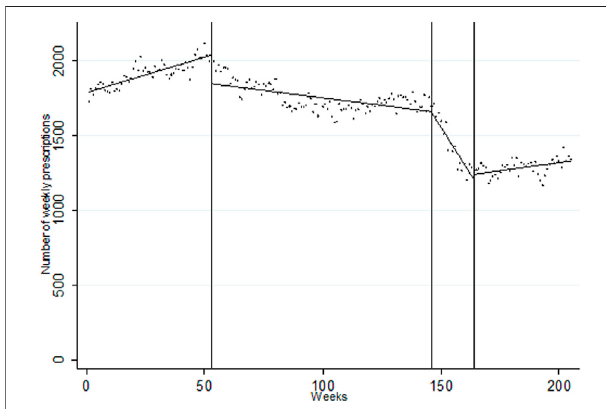
FIGURE 1 | Segmented linear regression trends of weekly series of IRF prescription for NCP, 2015 – 2018. Dots: observed weekly volume